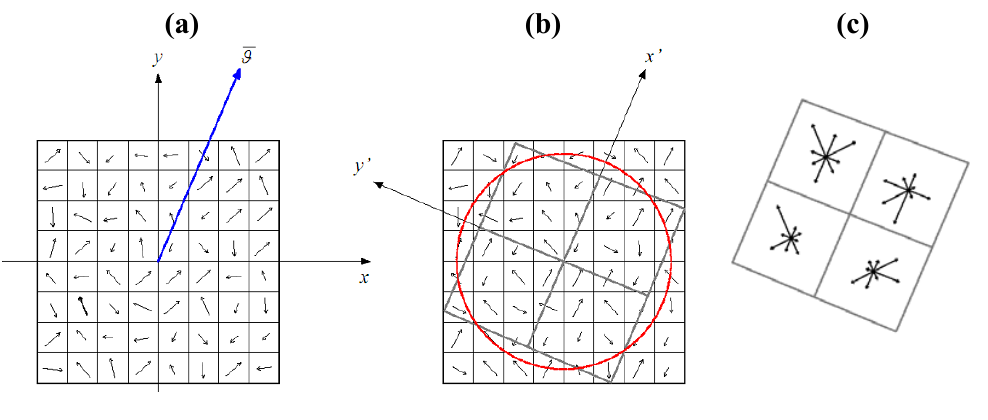
Figure 1. (a) The SIFT descriptor. Computation of the magnitude and orientation. (b) Orientation corrections and spatial coordinate transformation. (c) SIFT descriptor establishment. In the original implementation, there are 16 spatial